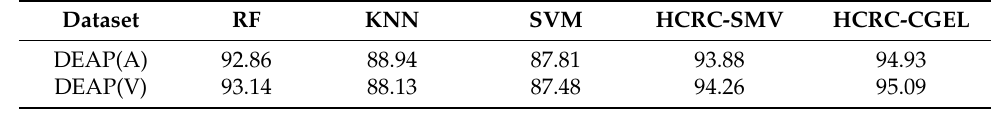
Table 2. Performance (%) of each method on DEAP database.